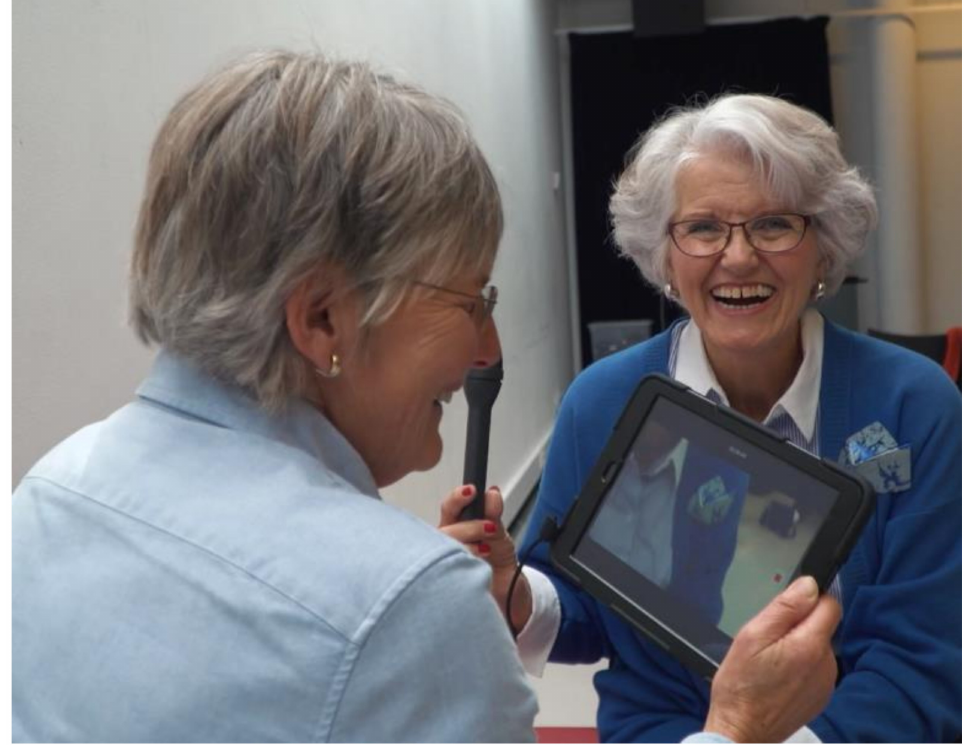
Figure 4. Participants in The Hague having fun